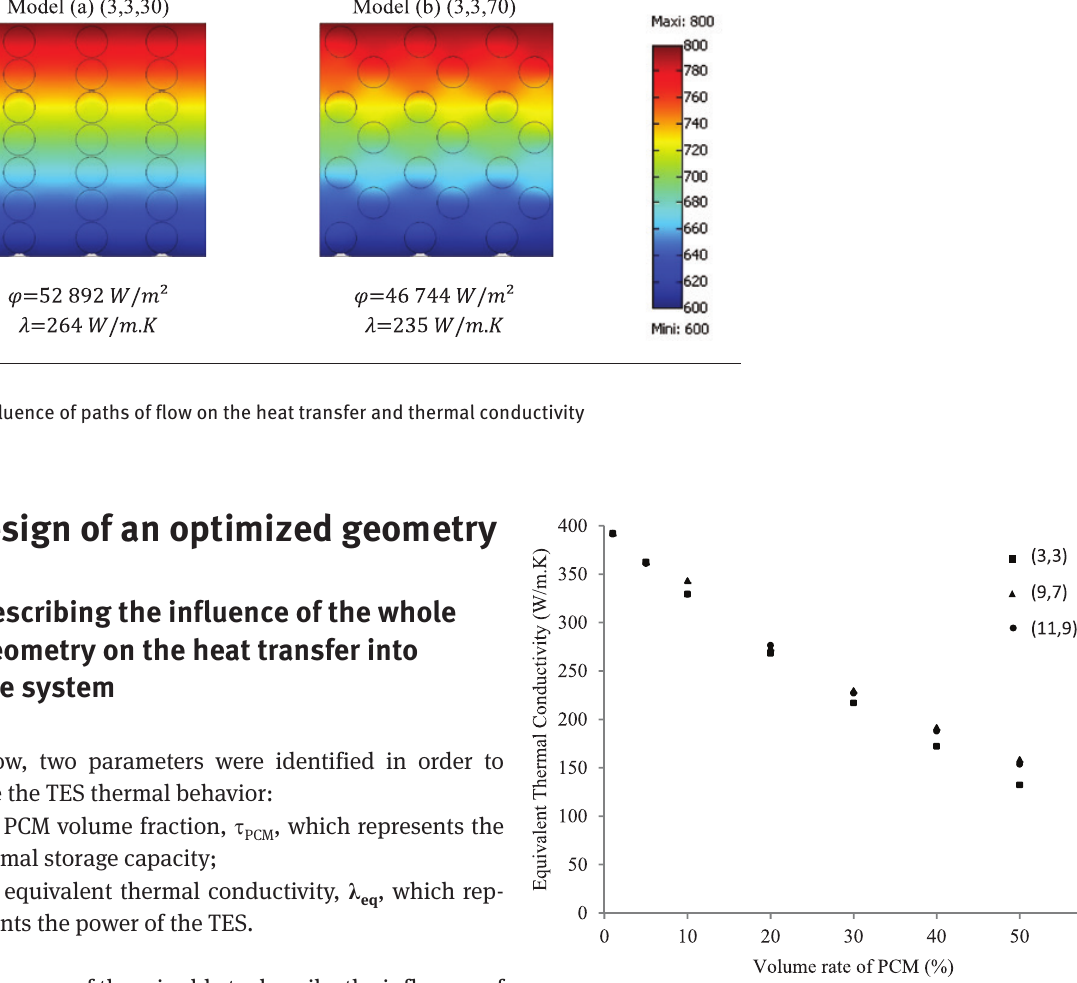
Fig. 9: Evolution of λ eq according to PCM volume